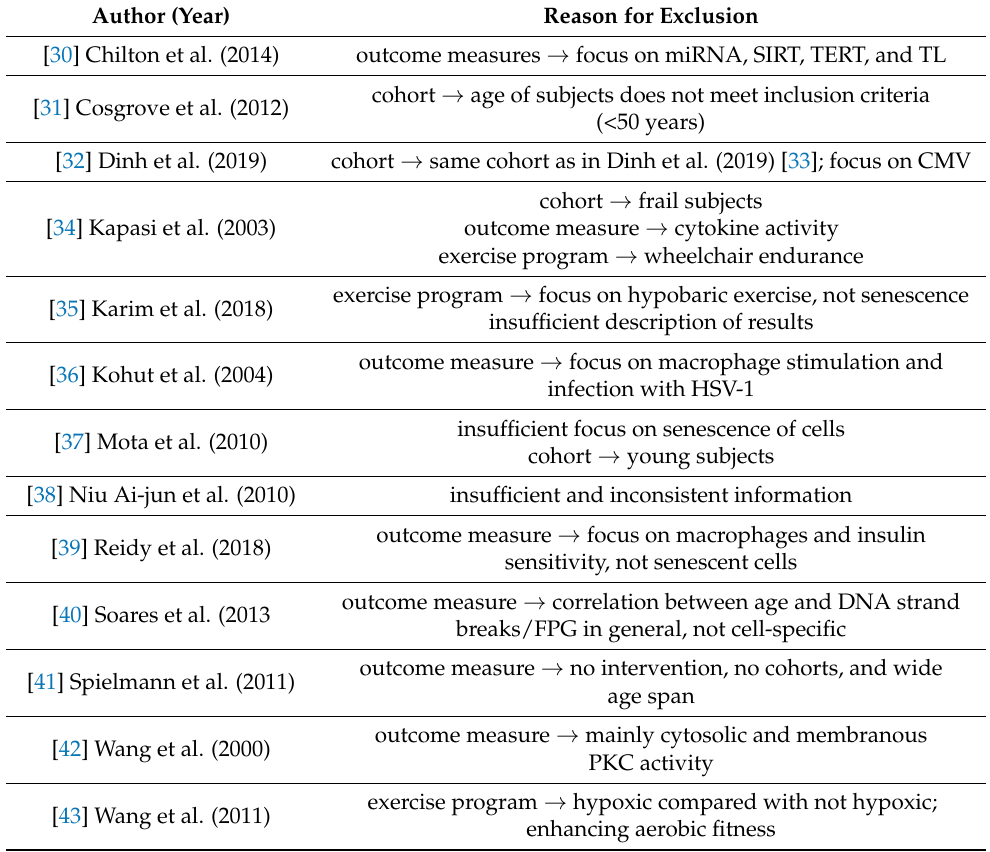
Table 4. Excluded studies with named reasons ( n =